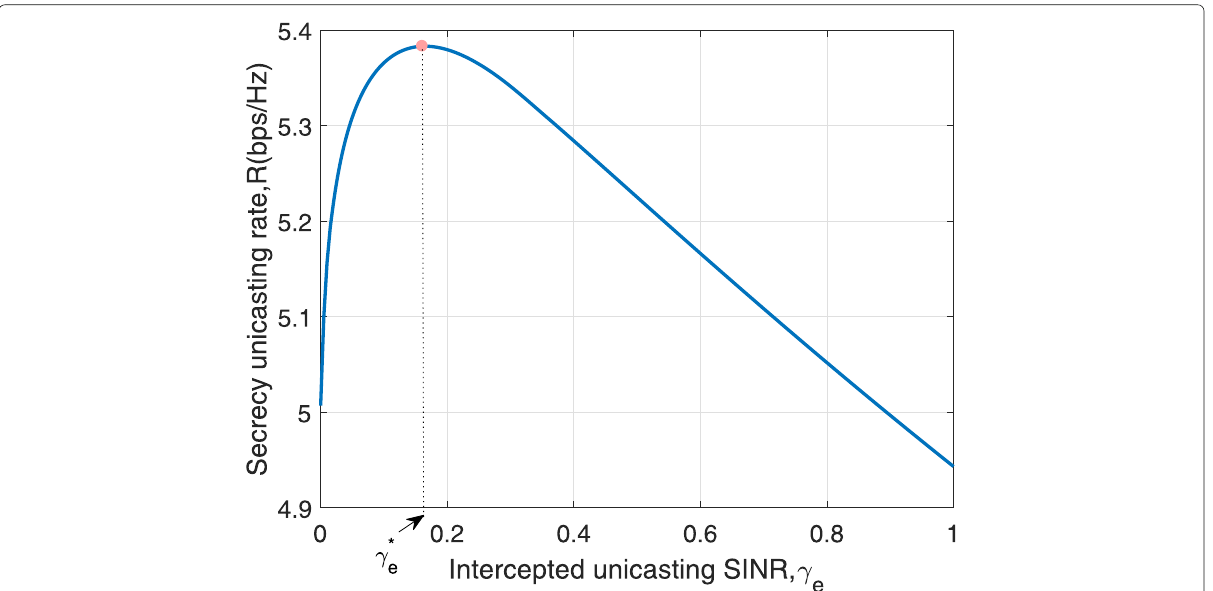
Fig. 2 Uniqueness of γ ∗ e in the multicast-unicast transmission system